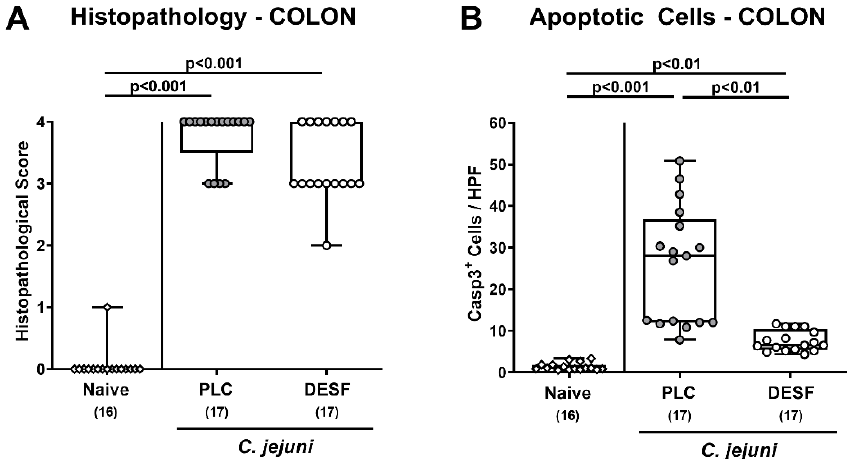
Figure 3. Microscopic inflammatory responses in the colon following C. jejuni infection of microbiota-depleted IL-10 − / − mice that had been pretreated with deferoxamine. Microbiota-depleted IL-10 − / − mice were subjected to desferoxamine (DESF, white circles) pretreatment via the drinking water starting 7 days prior infection or received autoclaved tap water only (PLC; grey circles). On days 0 and 1, mice were perorally infected with C. jejuni strain 81-176. On day 6 post-infection, microscopic inflammatory responses were assessed in colonic paraffin sections by quantification of ( A ) histopathological changes applying a standardized histopathological score and of ( B ) apoptotic colonic epithelial cells following immunohistochemical staining with an antibody against cleaved caspase-3 (Casp3). Indicated are the medians of Casp3 + cells within six representative high-power fields (HPF, 400 × magnification). Uninfected and untreated mice served as negative controls (white rhombus). Whiskers indicating the total range, boxes indicating the 25th and 75th percentiles of the medians (black bars inside boxes), significance levels ( p values) calculated by the Kruskal–Wallis test with Dunn’s post-correction, and the total numbers of analyzed mice (in parentheses) are given. Shown data were pooled from three independent experimental sets.